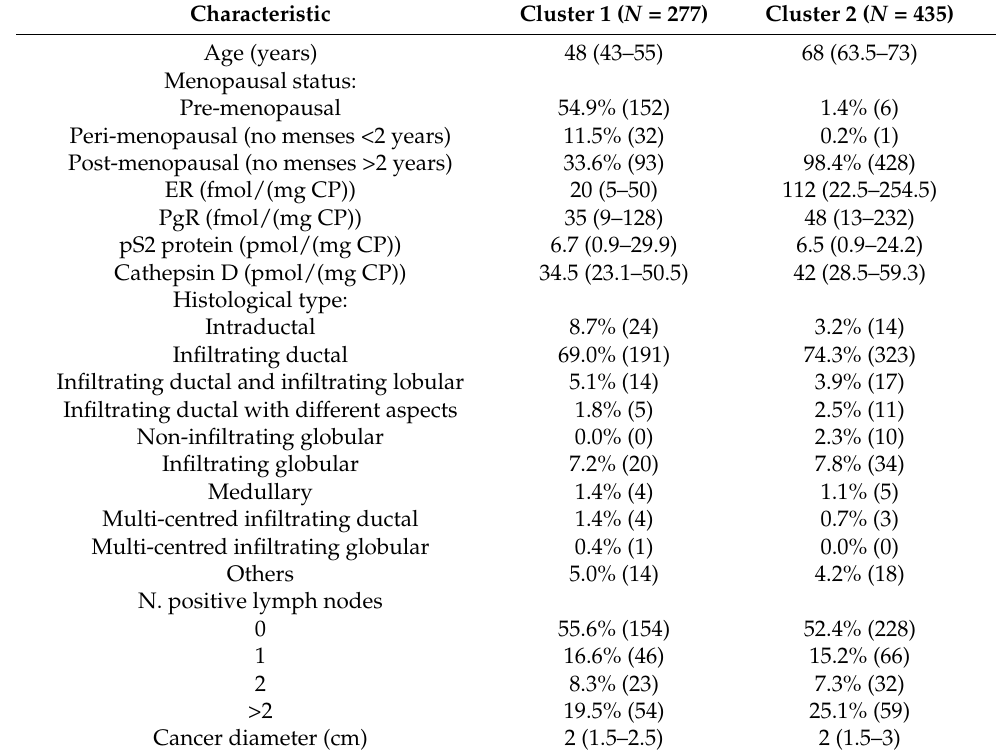
Table 5. Distributions of the variables in the two clusters obtained with HAC. Continuous variables are represented with median values (1st quartile–3rd quartile). Categorical variables with percentages (absolute